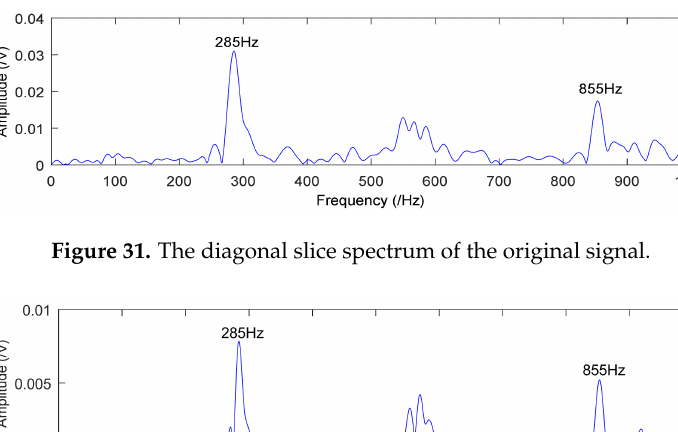
Figure 30. The time waveform after noise reduction.